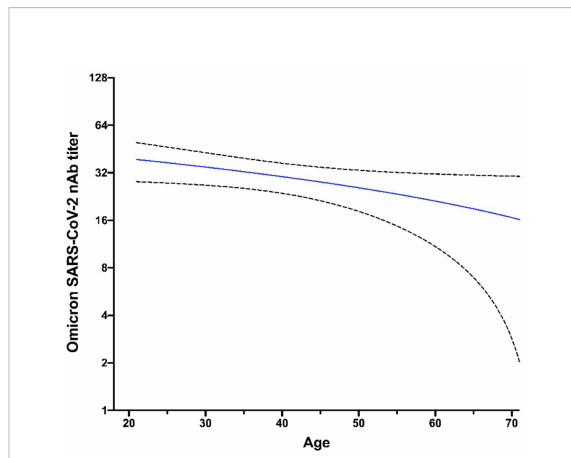
FIGURE 3 Immunogenicity of BNT162b2 at 180 days after being fully vaccinated. The neutralizing antibody (NAb) titers against the Omicron variant six months after being fully vaccinated according to age over or under 40 years and gender. Statistical comparison was made using the Kruskal-Wallis test with a con fi dence level of 95% and post hoc tests (or multiple benchmarks) HDS of Dunn were applied.